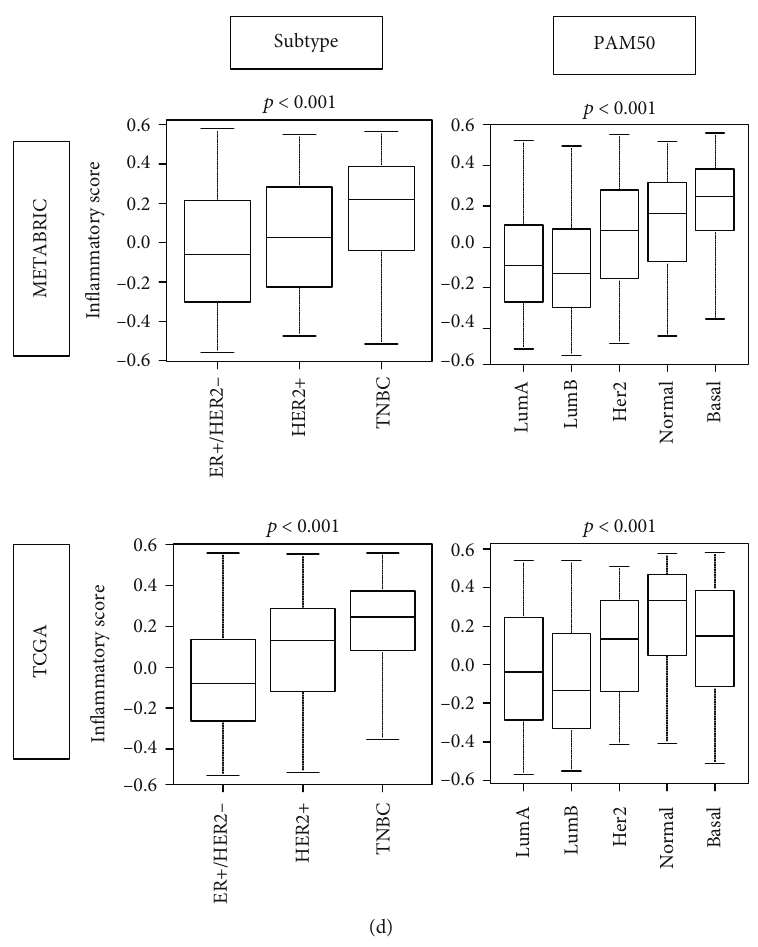
Figure 1: Association between in fl ammatory pathway score and the clinical factors in breast cancer. (a) Disease-speci fi c (DSS), disease-free (DFS), and overall survival (OS) of in fl ammatory score high (red line) and low (blue line) in whole METABRIC breast cancer cohort. Log- rank test was used to compare the groups with Kaplan-Meier survival curves. (b) Boxplots of the in fl ammatory scores by AJCC cancer stage, Nottingham pathological grade, and age at diagnosis ( < 40yo, 40-70 yo, and < 70yo) in both METABRIC and TCGA cohorts. (c) Gene expression levels of SphK1, SphK2, and S1P receptor 1 by high vs. low in fl ammatory score. (d) Boxplots of the in fl ammatory scores by subtype and PAM50 classi fi cations. Tukey-type boxplots show median and interquartile level values, and the ANOVA test is used to calculate p